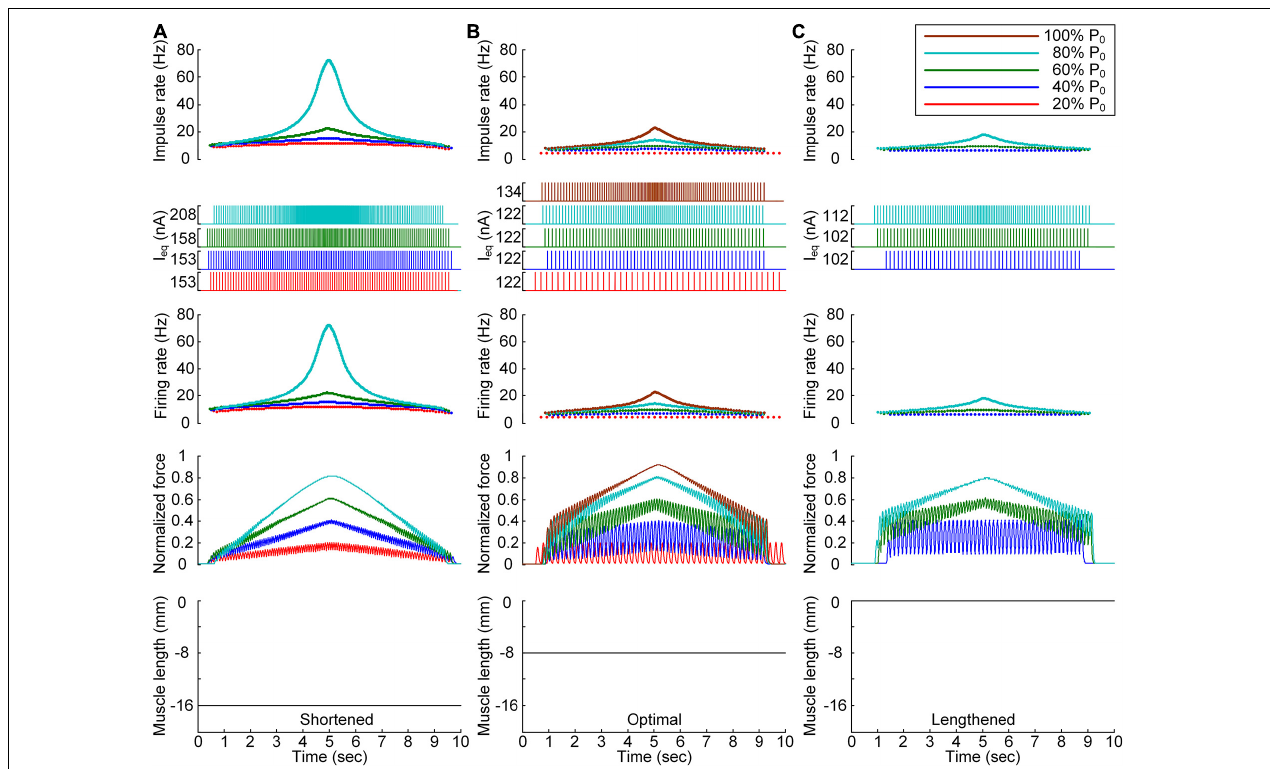
FIGURE 4 | Discrete stimulation waveforms for linear force production. Frequency and amplitude (two top panels ) of impulse current stimulation ( I eq ) applied to the somatic compartment, instantaneous firing rate ( upper middle ) in the motoneuron, and normalized muscle force ( lower middle ) produced by the muscle unit at the three muscle lengths ( bottom ): physiologically minimum (A) , optimal (B) , and maximum muscle lengths (C) . The level of force production produced by the motor unit is denoted as a percentage of the maximal isometric force (P 0 ) at the optimal muscle length and indicated with different